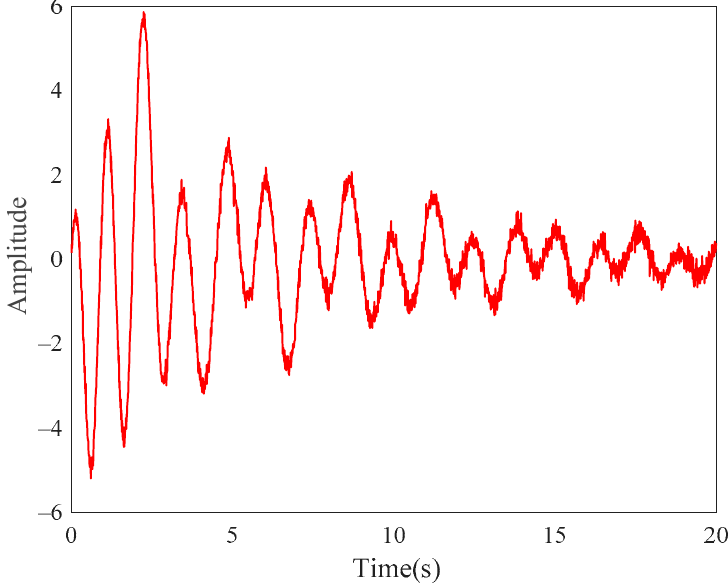
Figure 9. Simulated signal with Gaussian white noise at 20 dB SNR. The five effective IMFs and a residual signal are extracted by EMD to eliminate high- frequency noise as Figure 10, and the comparison of the synthesized signal c EMD ( t ) with signal B in Figure 11. The curve of c EMD ( t ) is smooth and extremely coincidence with that of signal B, which indicates that c EMD ( t ) has retained the dominant modes of the original DLFO signal. And c EMD ( t ) is conducive to modal identification by SSI and Prony following. Using the SSI method and Prony algorithm to identify c EMD ( t ), the estimated modal parameters are shown in Tables 6 and 7, respectively. To extract the true modes from the trivial modes, the parameter matching method is applied to match the full modal parameters in the similar frequency of Tables 6 and 7, and the matching results are displayed in Table